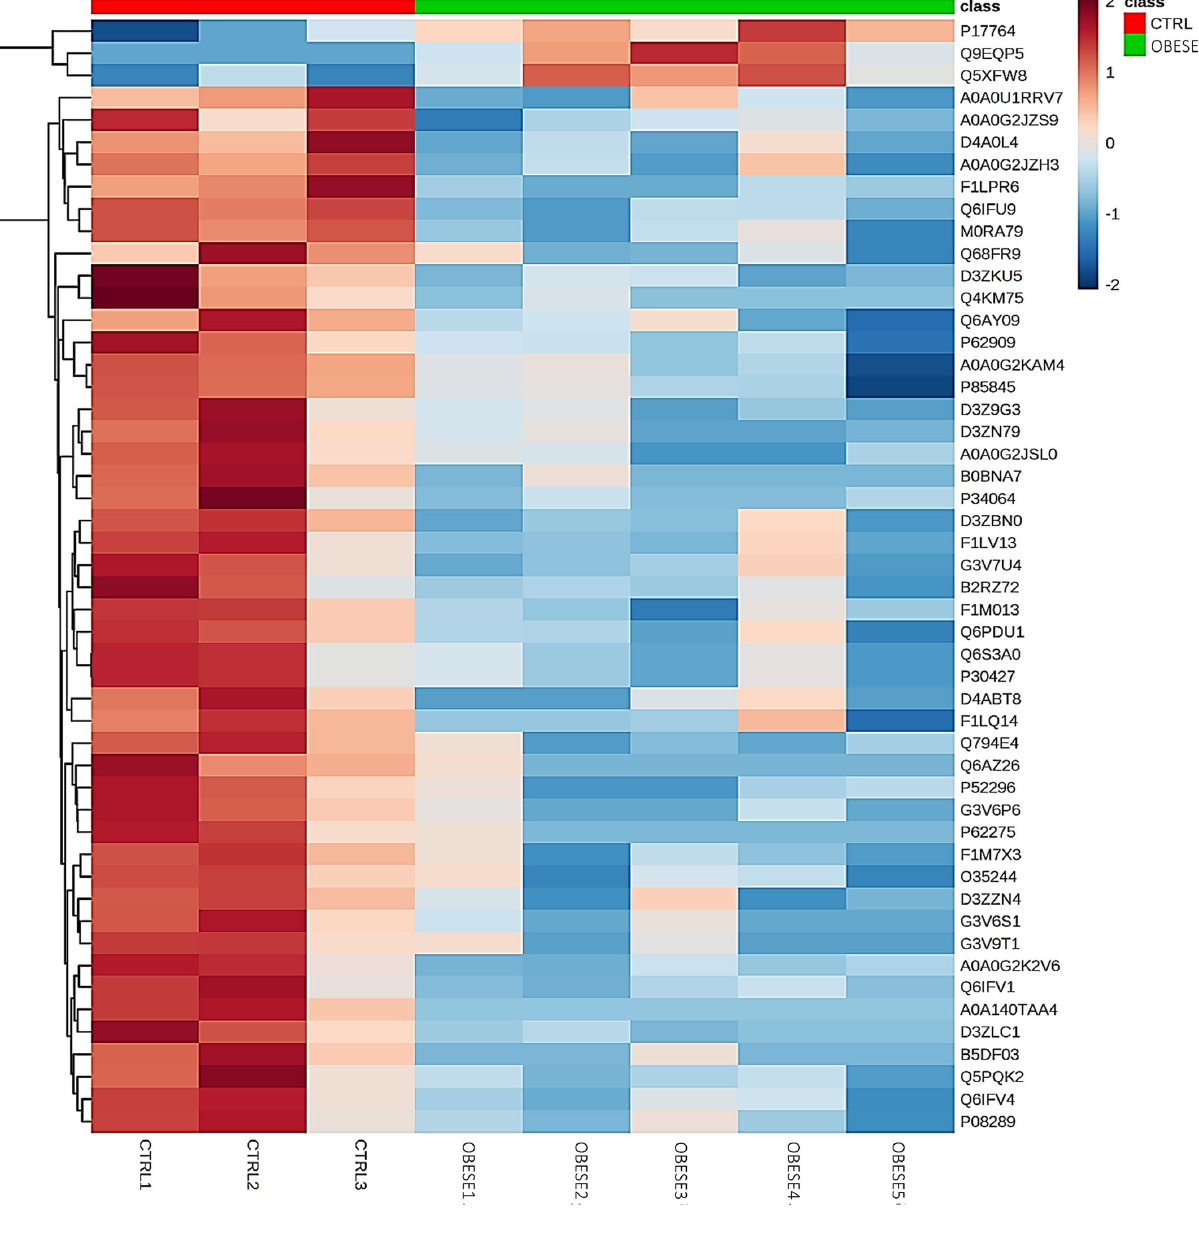
Figure 2. Hierarchical clustering of the top 50 proteins of increased and reduced abundance in the control (CTRL) and obese groups, as shown by the heat map. Data were classified by p ‐ value ( p < 0.05) and estimated using the Z ‐ score calculation on Log2 spectral count values, applying the Euclidean distance and average linkage method.